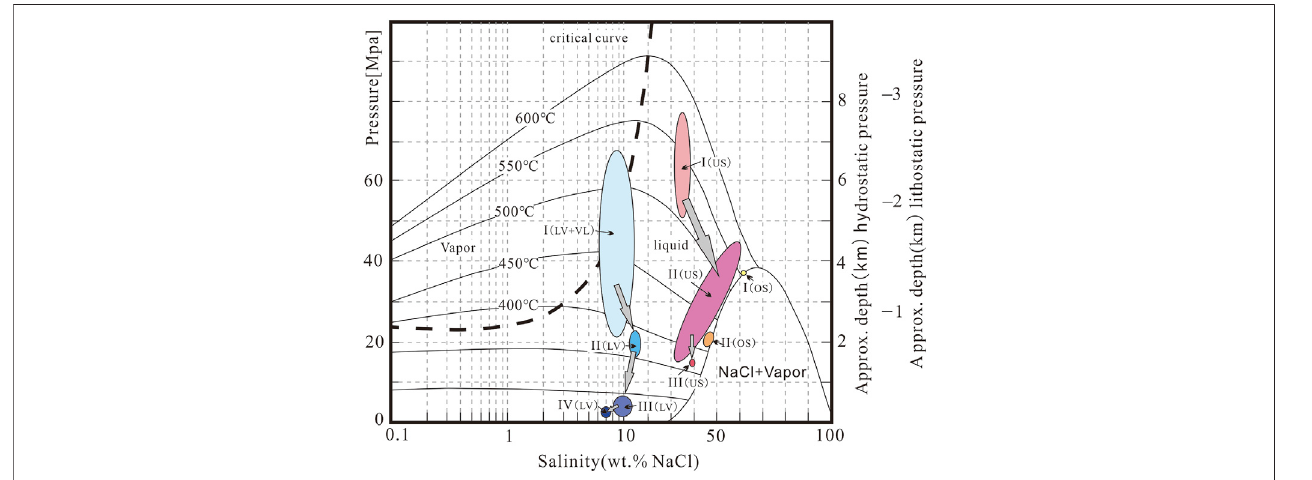
FIGURE 9 | Phase diagram of ore-forming fl uid inclusion showing the path of evolution of the fl uid (H 2 O – NaCl system) [drawn following Liao et al. (2014); Bakker (2018)]. In the skarn stage (I), the ore-forming fl uid under near the critical state evolved from a low – through – moderate to a high – salinity fl uid. In the greisen stage (II), the fl uid separated into a coexisting liquid and a vapor phase. The liquid phase had a salinity of 10 wt% NaCl, and that of the coexisting vapor phase was 2 wt% NaCl at 400 ° C.Forthemixingofthemeteoricandthemagma fl uids,thesalinityofthetypeVLinclusionsinstageIIIcouldnotbecalculatedaccurately.Adetaileddiscussion oftheevolutionofthe fl uidisprovided inthetext. StagesI – IVrepresentthedifferentstages ofmineralization.LV,VL,OS,and USarethetypes of fl uidinclusions,seetext in detail.